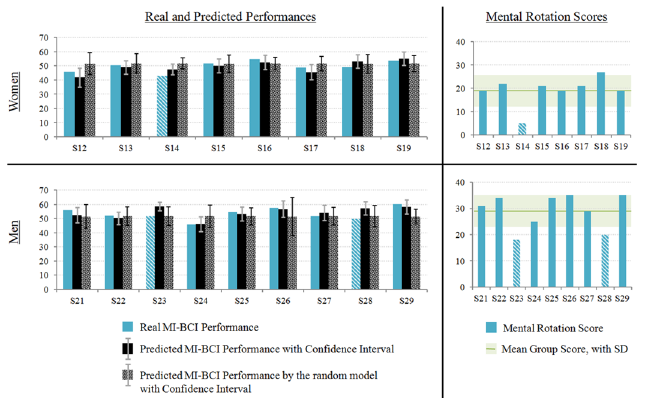
Fig 8. Real and predicted BCI performance as well as Mental Rotation scores according to the gender. Women ’ s results are shown at the top, men ’ s results on bottom. On the left, the graphical representation of the real (left) and predicted (right) BCI-performance of each participant, with the corresponding confidence intervals. On the right, the mental rotation scores of each participant with the horizontal line representing the mean score of the group. The three participants for whom the model overrated the performance are those with the lowest mental rotation scores (striped